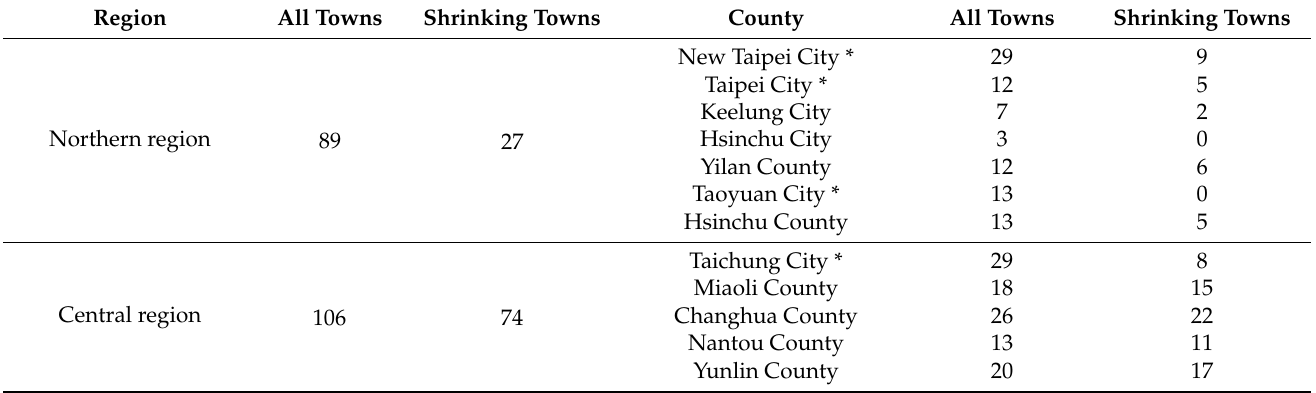
Table 7. Number of shrinking towns in each region and